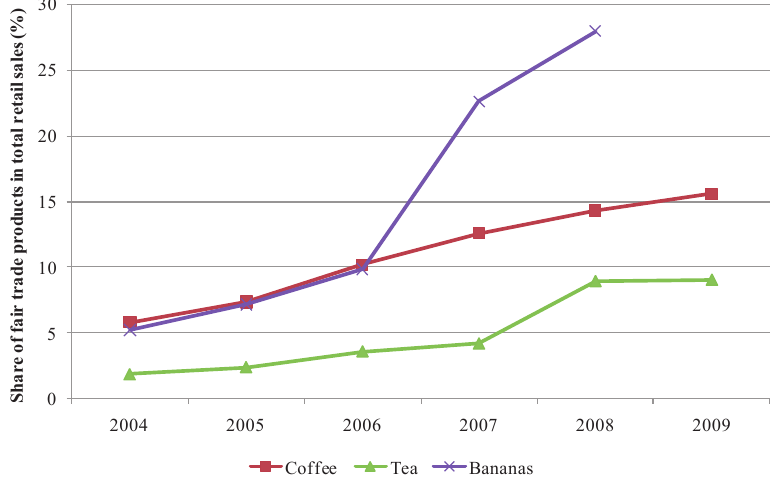
Figure 6. Share of selected fair trade products in total retail sales in the UK (%, 2004-2009)